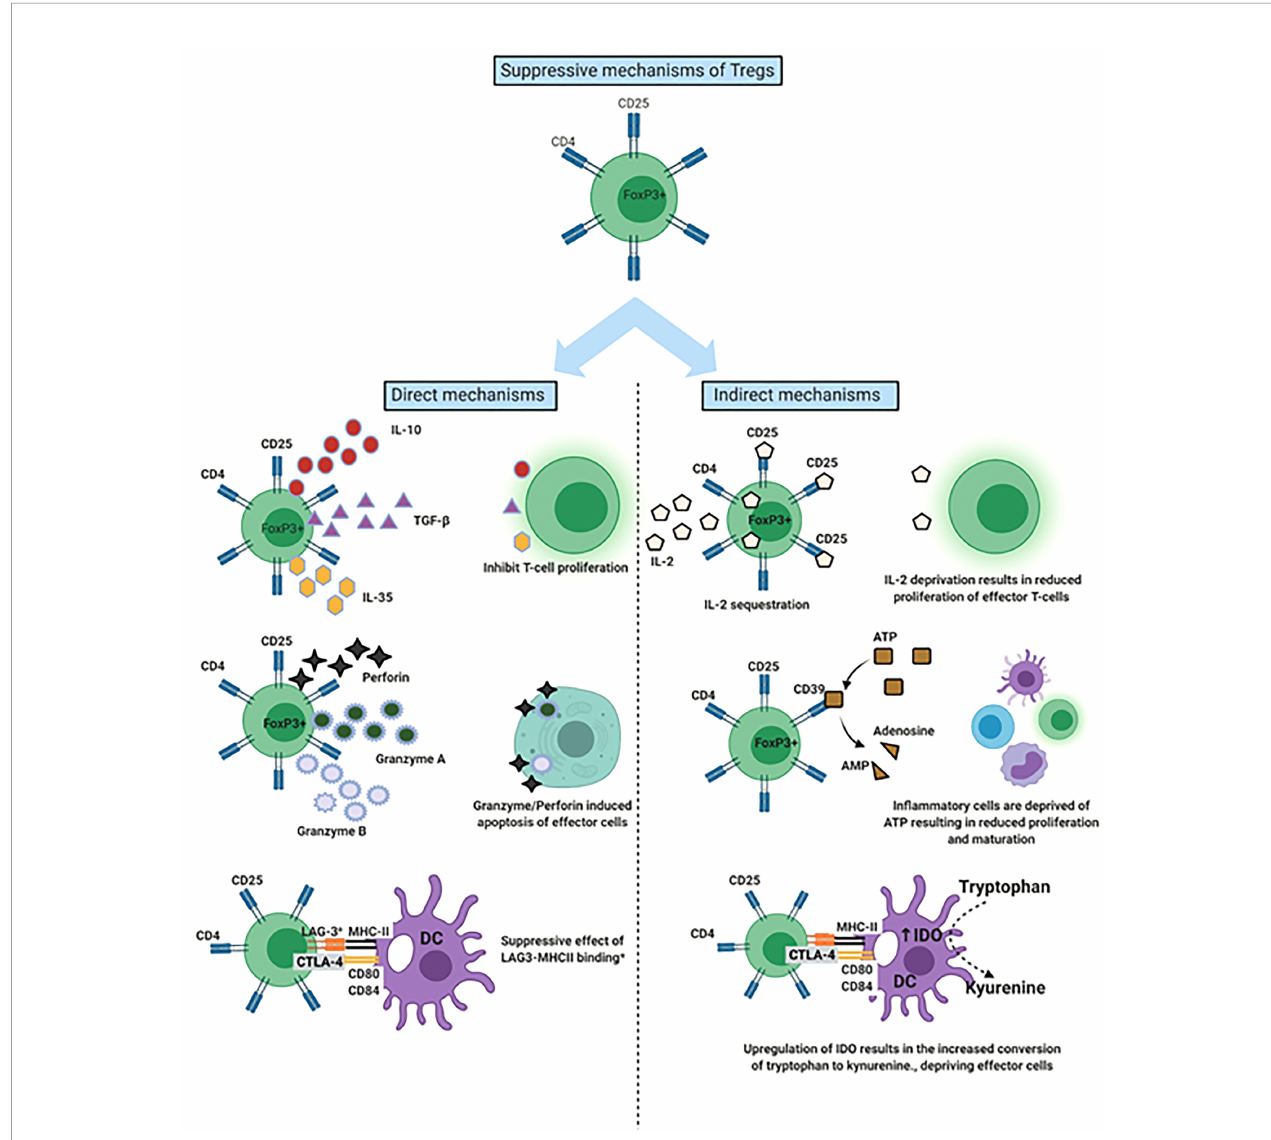
FIGURE 1 | Mechanisms by which Regulatory T cells (Tregs) suppress the immune response. Demonstration of both the direct and indirect mechanisms of Tregs. a LAG-3 involvement most characteristic of T-regulatory type 1 cells. DC, Dendritic cell; LAG-3, Lymphocyte activation gene 3; IDO,